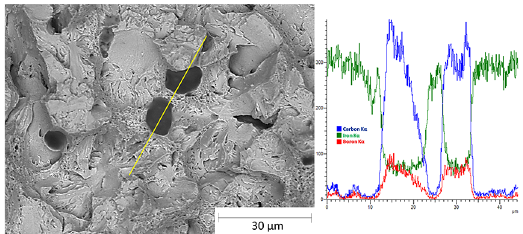
Figure 11. Semi-quantitative compositional analysis of Q&T specimen via EDS indicating carbon and boron in